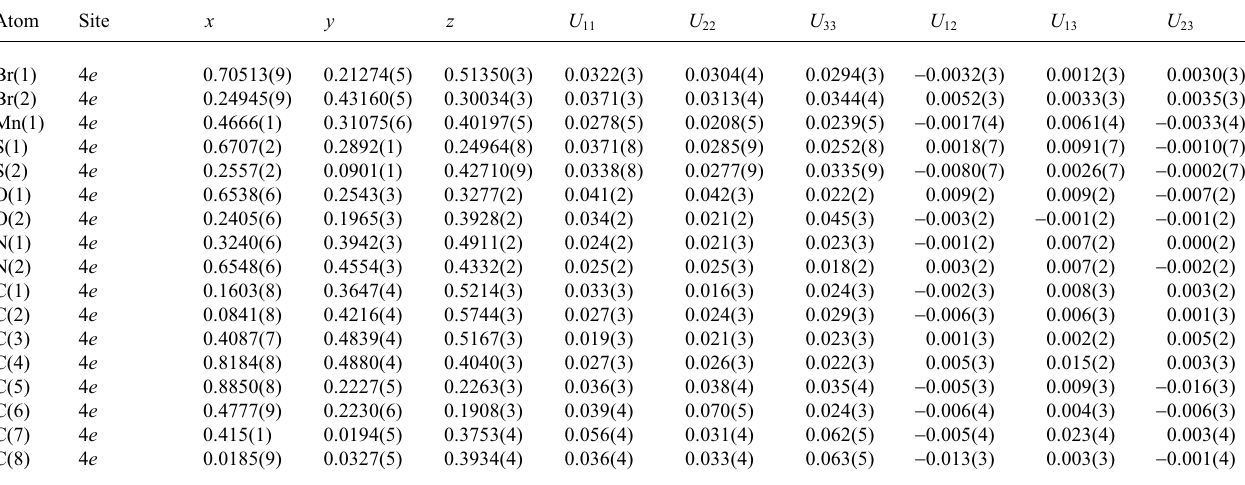
Table 3. Atomic coordinates and displacement parameters (in Å 2